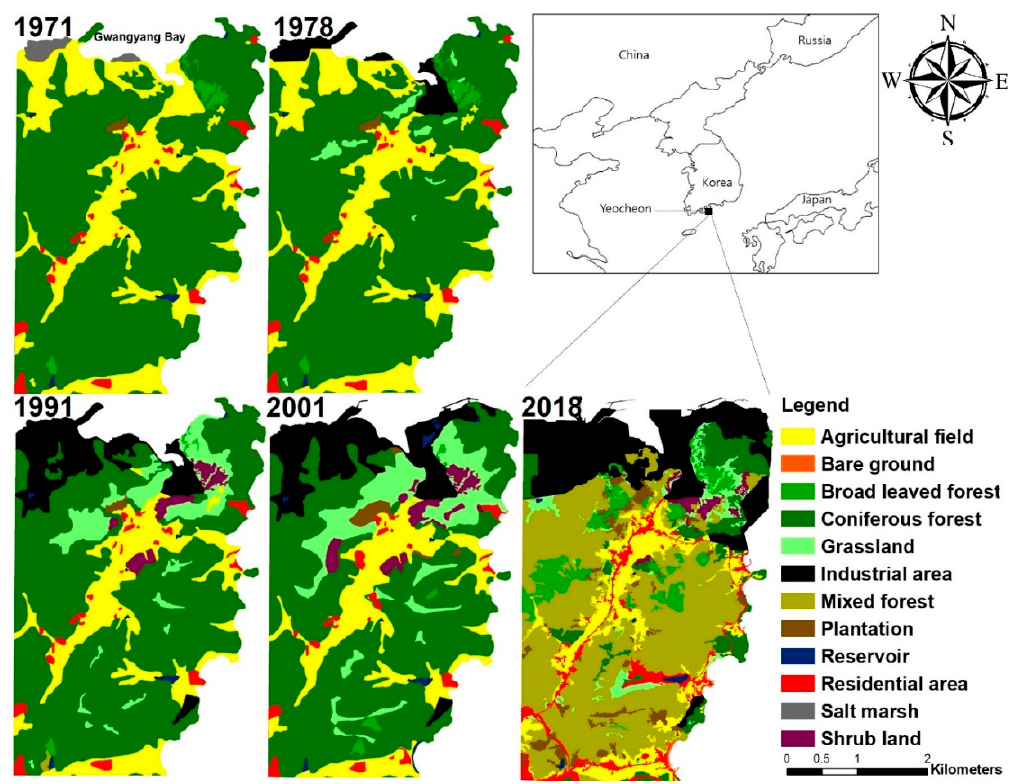
Figure 7. Maps showing the landscape change near the Yeocheon industrial complex.